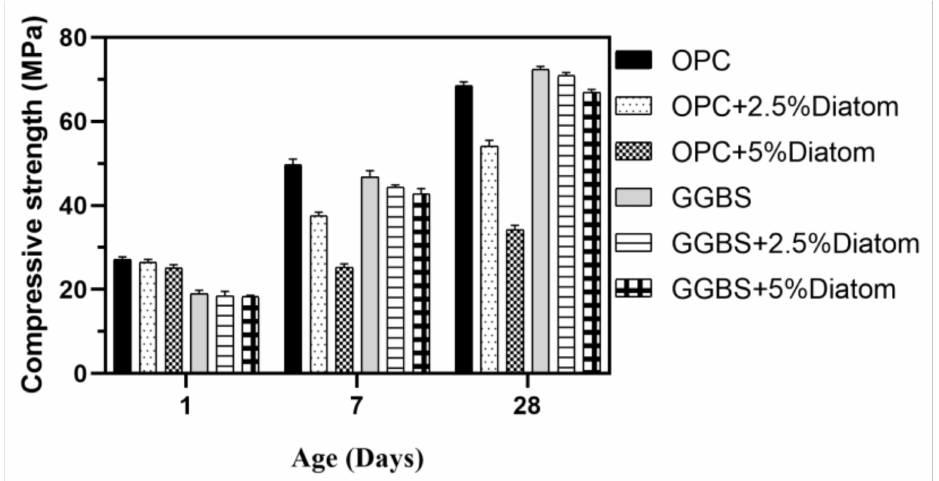
Figure 2. Compressive strength results of different samples at ages of 1, 7 and 28